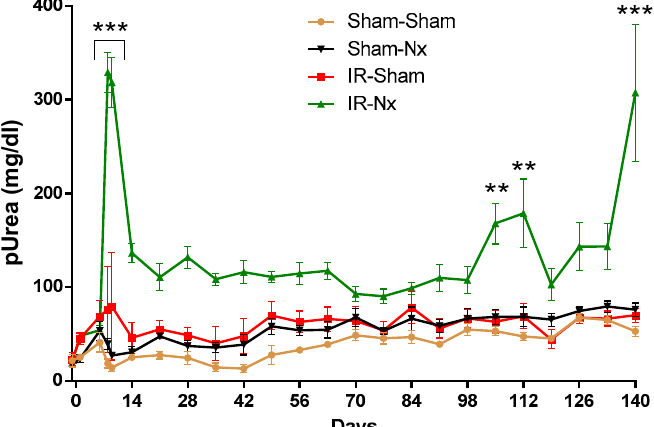
Figure 2. Plasma urea of mice in the long-term study. Samples were taken on days -1, 1, 6, 8, 9, 14 and once a week thereafter. Data are expressed as mean ± SEM; two-way ANOVA with Tukey’s post hoc test; **: p < 0.01 and ***: p < 0.001; IR-Nx (green) vs. all other groups.